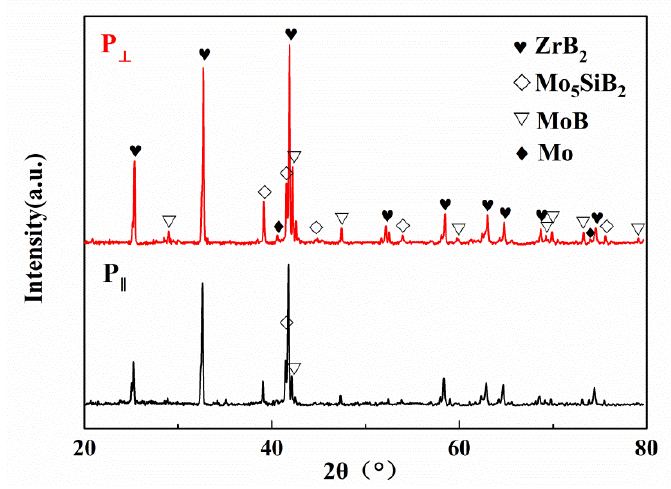
Figure 4. XRD patterns of the planes parallel to the interface (P ∥ ) and perpendicular to the interface (P ⊥ ) in the laminated ceramics.